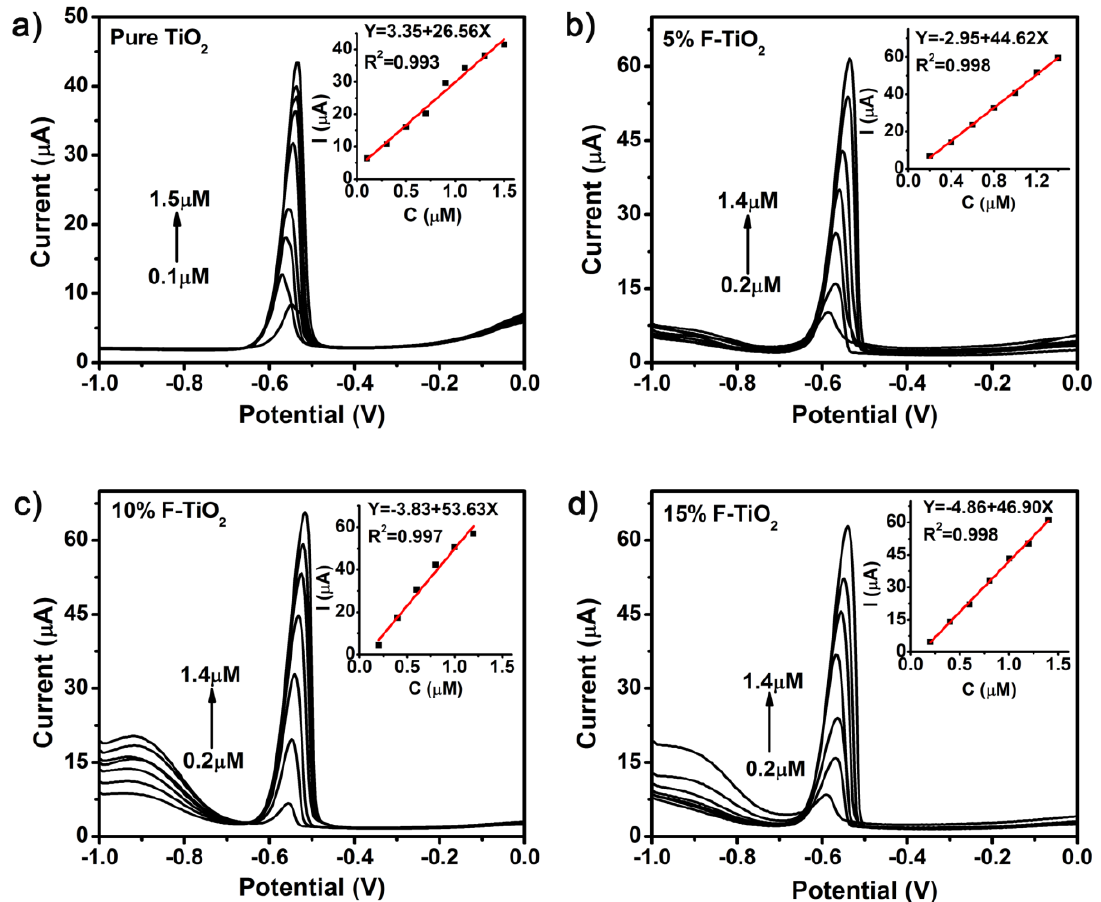
Figure 4. SWASV responses of ( a ) pure TiO 2 ; ( b ) 5% F-TiO 2 ; ( c ) 10% F-TiO 2 and ( d ) 15% F-TiO 2 modified electrodes toward Pb(II) at different concentrations in 0.1 M NaAc-HAc solution (pH 5.0). The insets show the corresponding calibration plots.